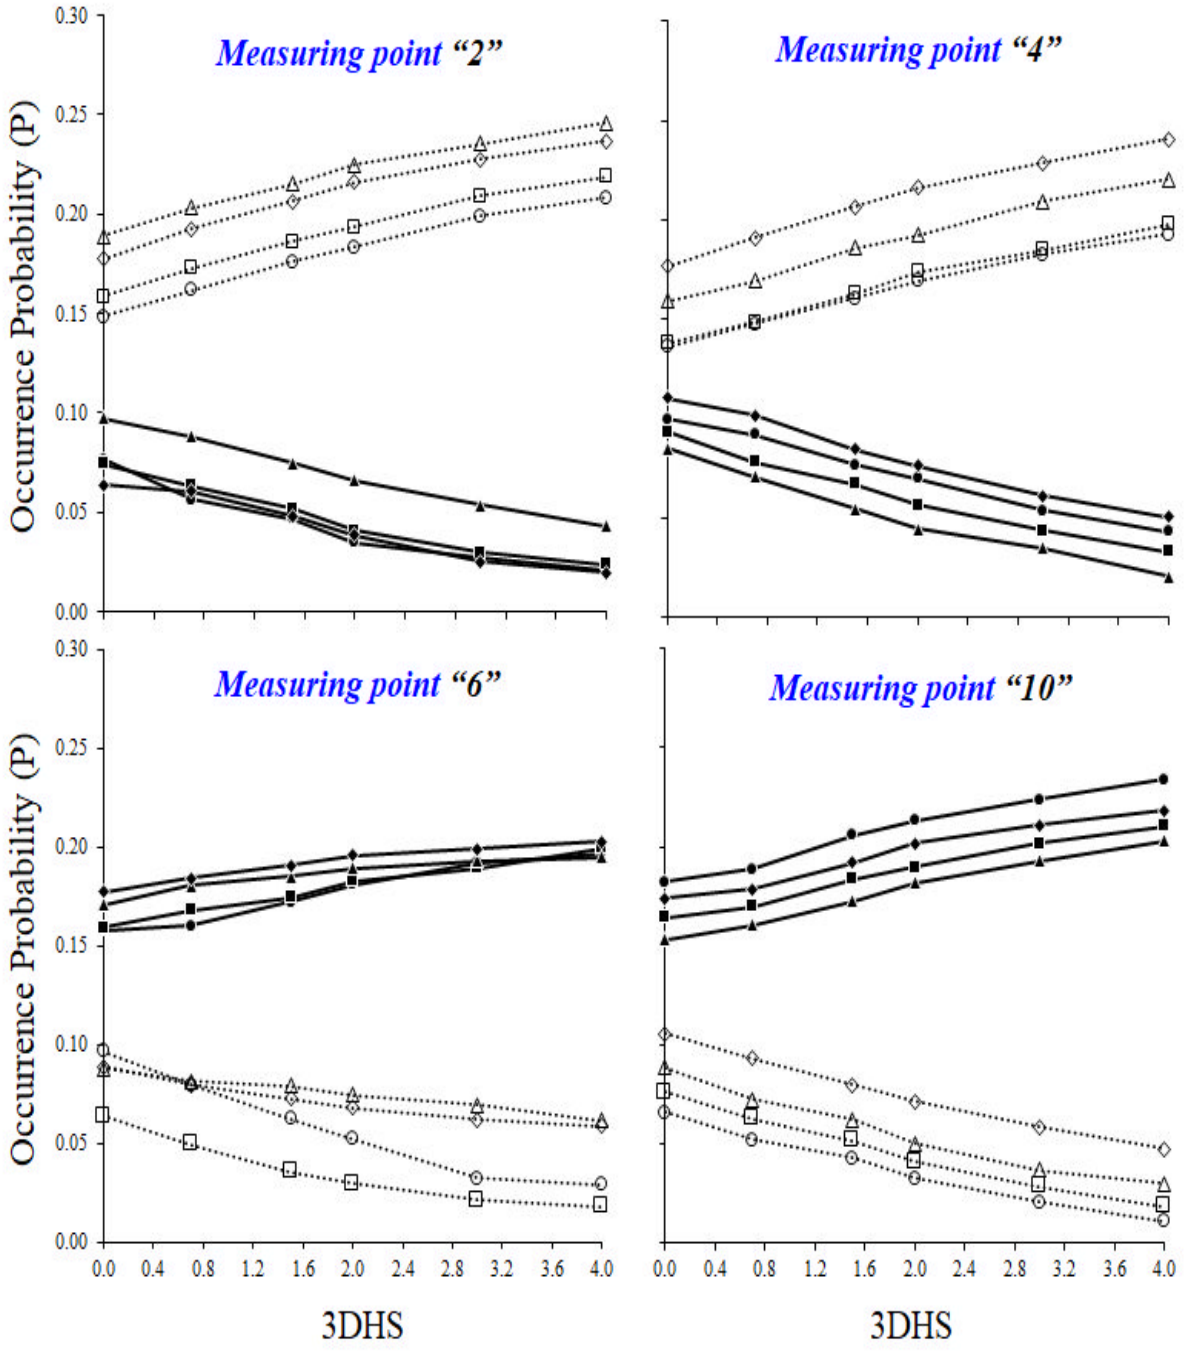
Figure 14. Depth-averaged occurrence probabilities of the octagonal bursting events with 3DHS values for the experimental run 6R: P 1 (filled circles), P 2 (unfilled circles), P 3 (filled squares), P 4 (unfilled squares), P 5 (filled triangles), P 6 (unfilled triangles), P 7 (filled diamonds), and P 8 (unfilled diamonds). Continuous lines indicate odd octagonal events, while dashed lines denote even events.